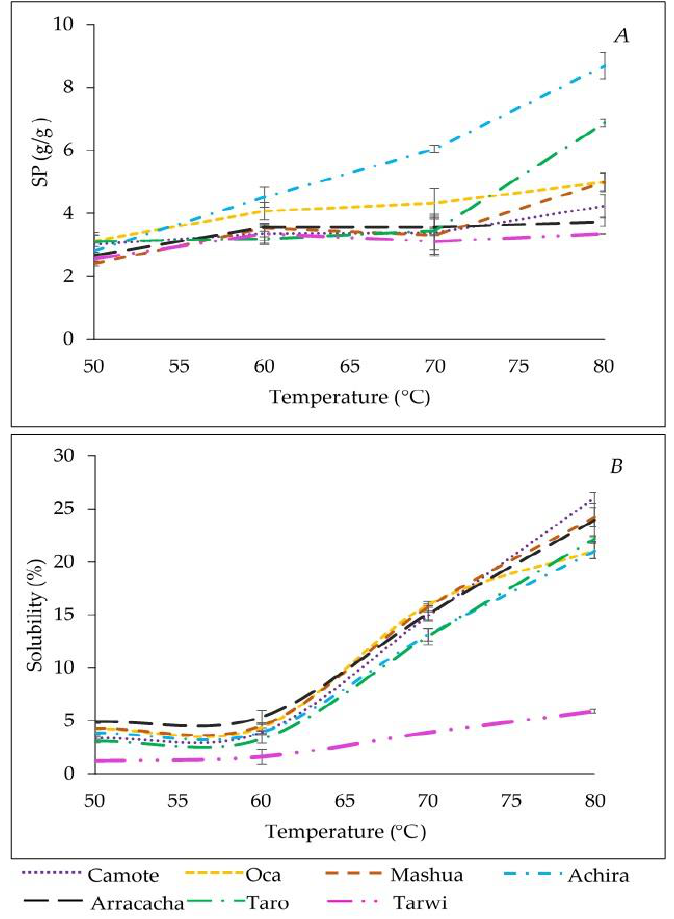
Figure 3. ( A ) Swelling power; ( B ) solubility of flours as a function of the temperature (50 – 80